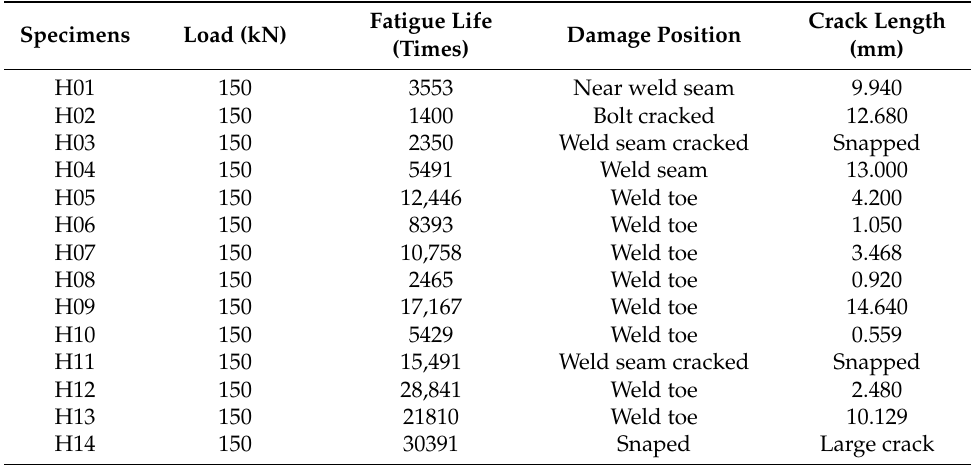
Table 5. Test results of T-type tube-plate joint.